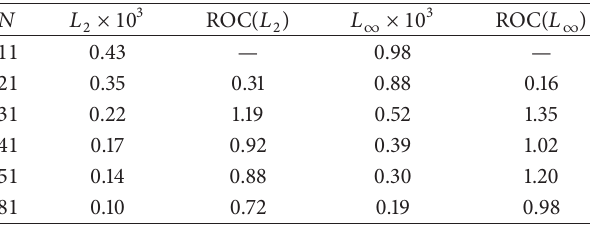
Table 8: Error norms and rate of convergence for various numbers of grid points at 𝑡 = 10 .